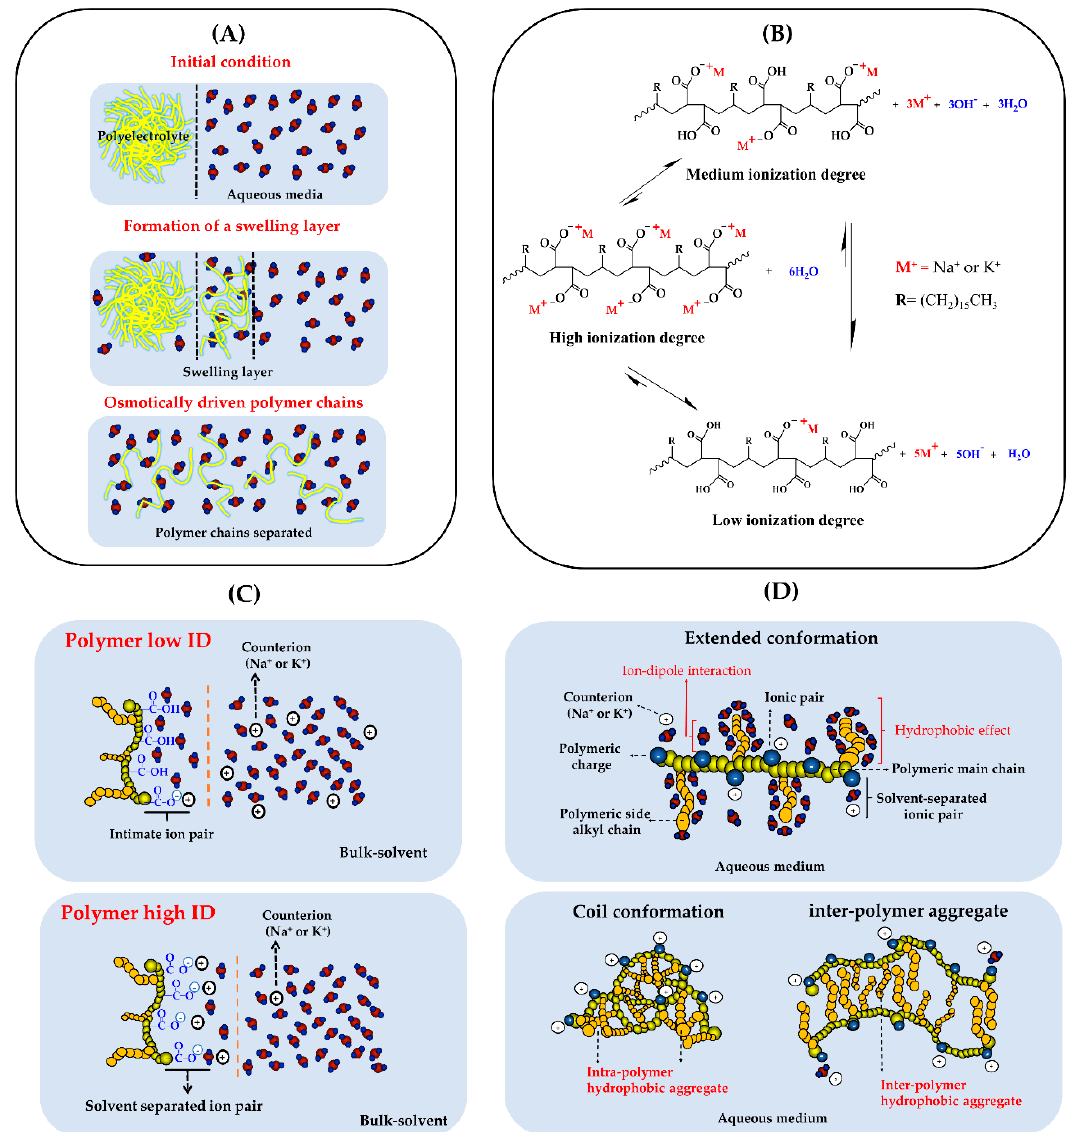
Figure 3. Scheme of the processes of: ( A ) Polyelectrolyte solubilization; ( B ) Thermodynamic equilibrium between carboxylate and carboxylic acids groups of polyelectrolytes; ( C ) Migration of the counterions from polyelectrolyte interface towards the bulk-solvent; ( D ) Configurations of polyelectrolytes solubilized in aqueous medium.